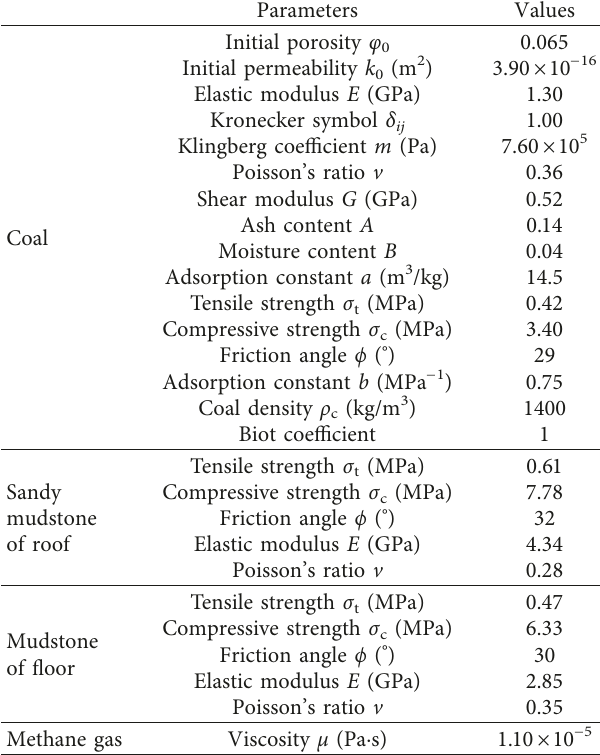
2 gas release port.